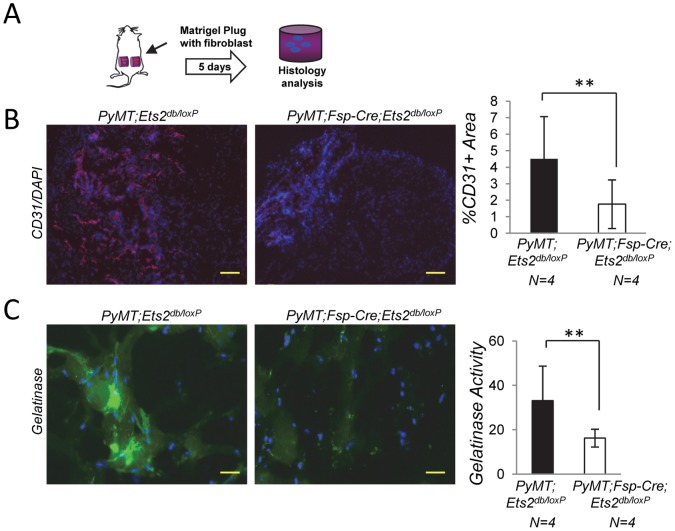

Ets2 regulation of angiogenesis and ECM remodeling is tumor cell independent.
A. Experimental strategy of matrigel plug assay. B. Left: CD31 staining (red) in matrigel plugs containing either PyMT;Ets2db/loxP or PyMT;Fsp-Cre;Ets2db/loxP tumor fibroblasts. Scale bar, 200 µm. Slides were counterstained with DAPI (blue). Right: graph represents percent CD31 positive area quantified using MetaMorph Software (n = 4, bars represent means ± SD, **P<0.01, Welch’s t-test assuming unequal variance). C. Right: gelatinase in situ zymography for MMP9 activity (green) of matrigel plugs containing primary fibroblasts of indicated genetic groups. Scale bar, 50 µm. Right: graph representing fluorescence intensity quantified using MetaMorph Software (n = 4, bars represent means ± SD, **P<0.01, Welch’s t-test assuming unequal variance).